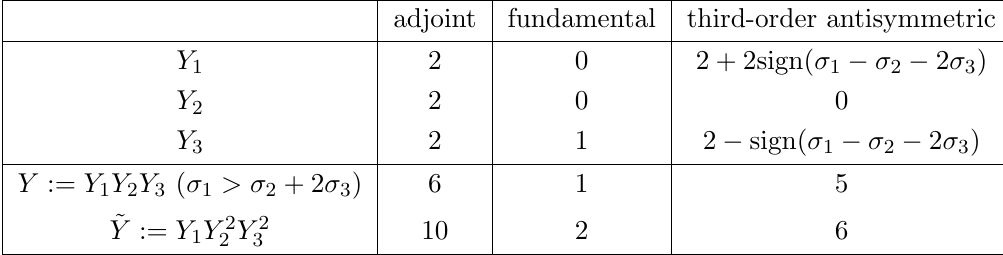
Table 5 . Fermion zero-modes for the USp(6) Coulomb